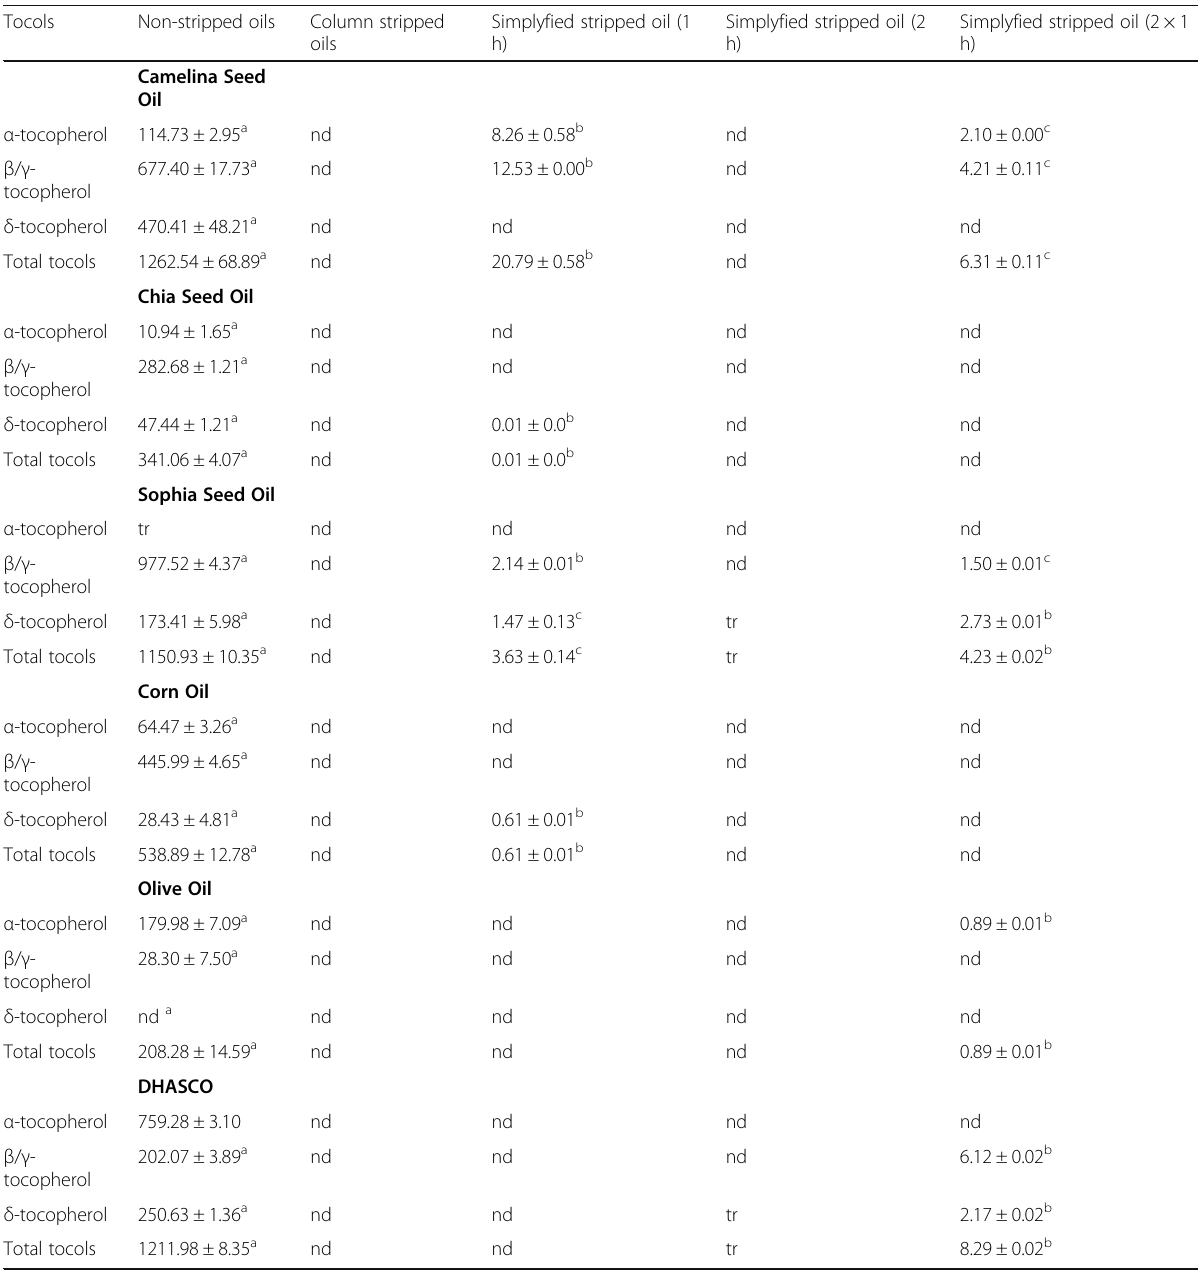
Table 1 Tocol concentration (mg/kg of oil) in the original, column stripped, and simplified stripped method (1 h, 2 h, and 1 h twice) of camelina seed, chia seed, sophia seed, corn, olive oils, and DHASCO